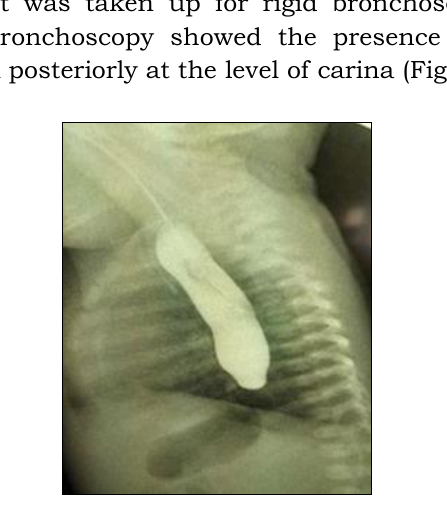
Figure 2: Contrast esophagogram showing dilated upper pouch ending at the level of